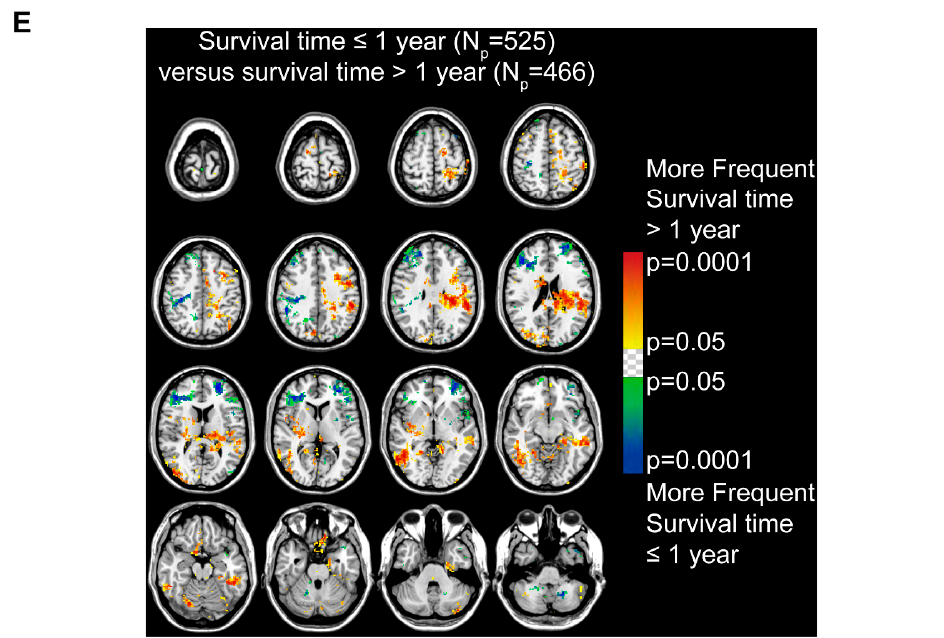
Figure 5. Analyses of the overall survival (OS) and analysis of differential involvement (ADIFFI) of survival-related localization of BMs. ( A ) OS analysis comparing patients with BMs originated from different primary malignancies. ( B ) OS analysis comparing patients with 1, 2, and ≥ 3 BMs ( n = 1 vs. n = 2, p = 0.605; n = 1 vs. n ≥ 3, p = 0.0010; n = 2 vs. n ≥ 3, p = 0.0347). ( C ) OS analysis comparing patients with or without infratentorial involvement of BMs. ( D ) OS analysis comparing patients who received different treatments (surgery alone vs. WBRT alone, p = 0.005; surgery plus WBRT vs. WBRT alone, p = 0.006; surgery plus SRS vs. WBRT alone, p = 0.005). ( E ) p -value heatmap constructed by ADIFFI displayed BMs cluster predominance when comparing patients with OS ≤ 1 year with OS >1 year. BMs refer to brain metastases. N p refers to the number of patients. WBRT refers to whole-brain radiotherapy. SRS refers to stereotactic radiosurgery. *: p < 0.05 and **: p <